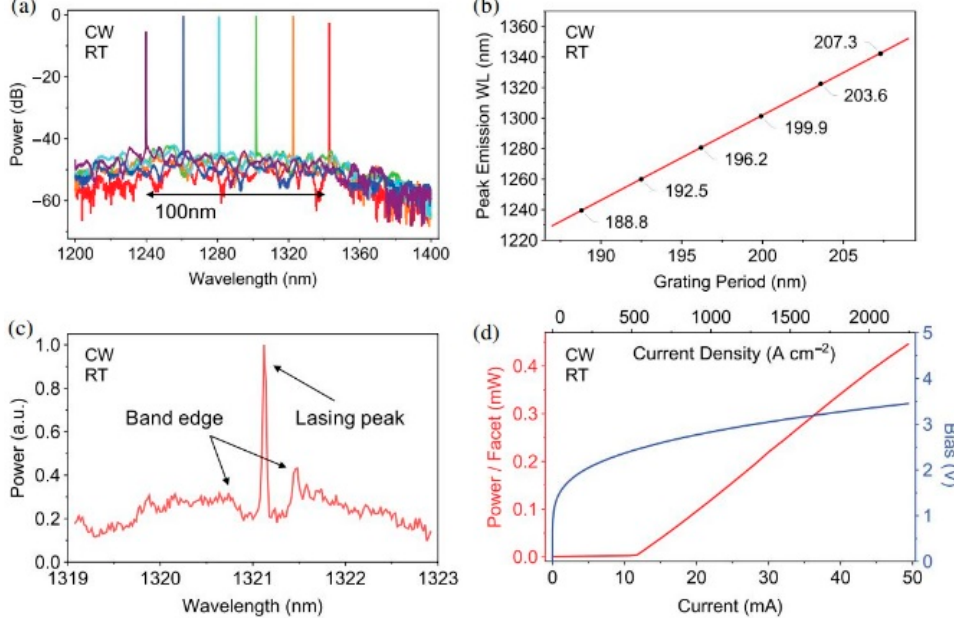
Figure 21. CW test results of the silicon-based DFB laser array at RT. ( a ) Optica spectra of a DFB laser array with different grating periods. ( b ) Peak emission wavelengths of the DFB array plotted against grating period values. ( c ) Zoomed-in optical spectrum of a single DFB laser operating just below threshold. ( d ) Light-current-voltage curve of a single 1 mm long silicon-based DFB laser. Reproduced with permission from [174]. The Optical Society, 2018.